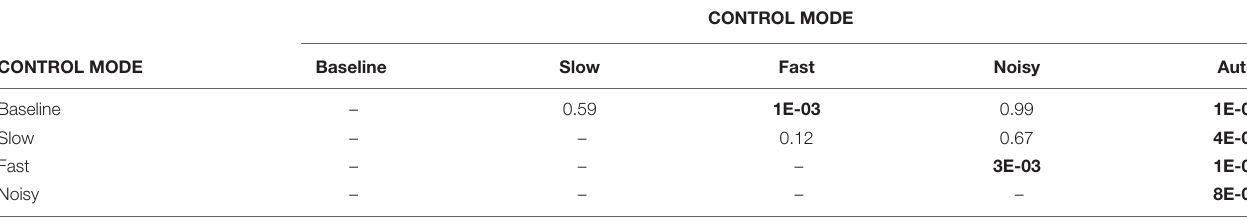
TABLE 4B | Post hoc comparisons ( p -values) for control efficiency across control modes on rigid surface.